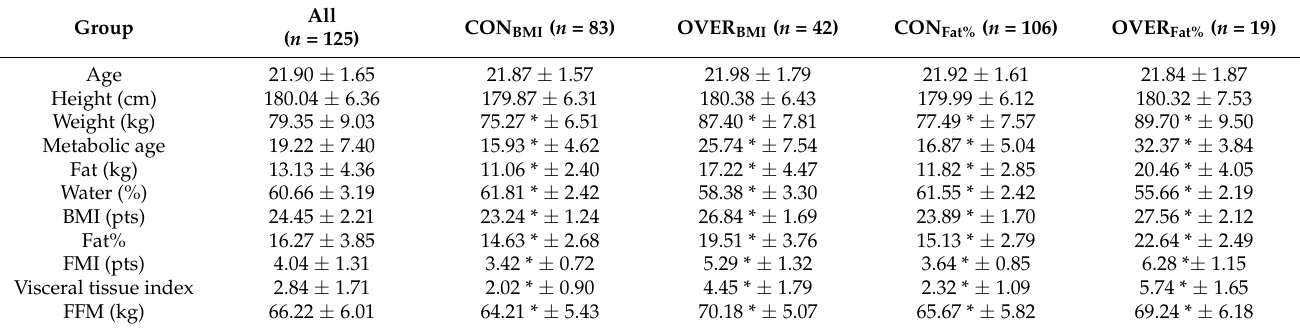
Table 1. Anthropometry and body composition of the